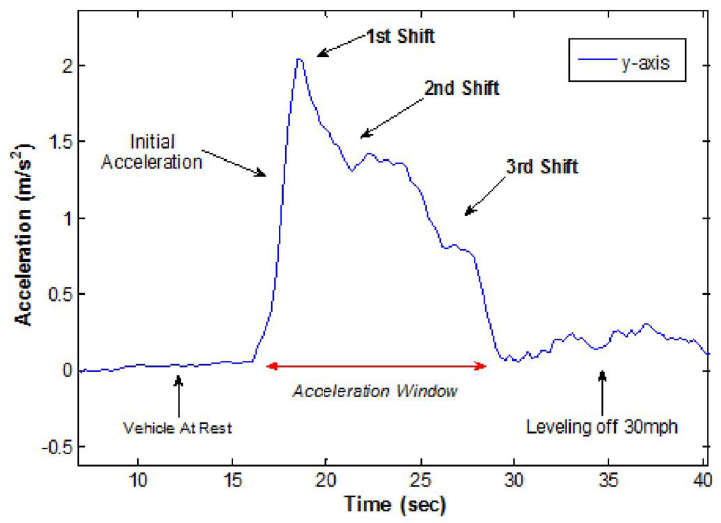
Figure 3. Engine gear shift analysis of a vehicle based on the y-axis accelerometer data